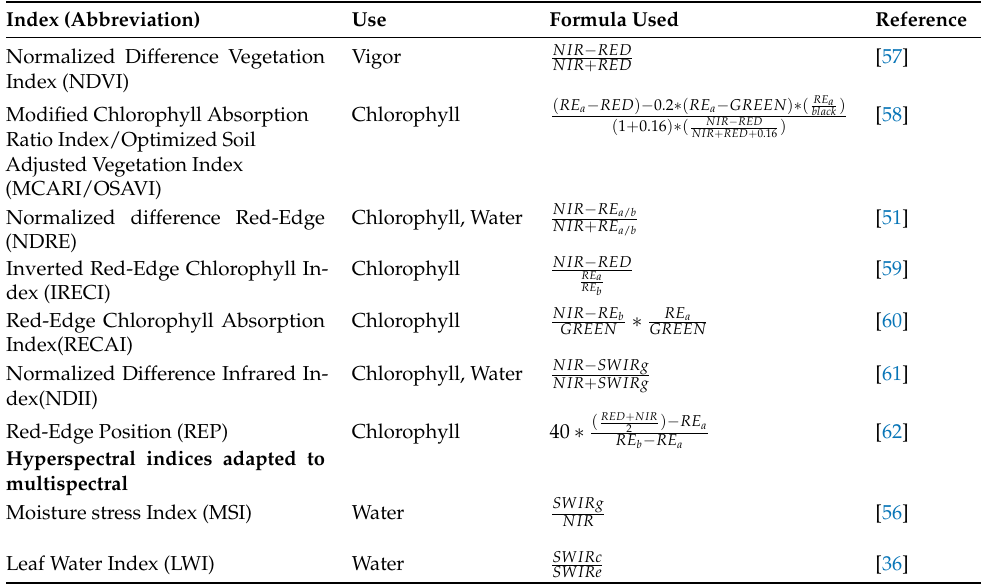
Table 7. Multispectral vegetation indices selected according to the previous analyses using raw wavelengths and literature.